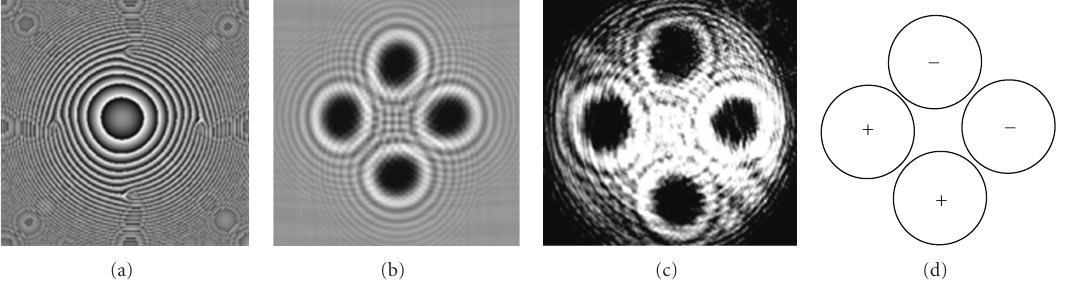
Figure 4: Fresnel lens with two positive and two negative charge vortices embedded at o ff -axis locations. (a) Phase distribution displayed on SLM. (b) Simulated intensity distribution near the focal plane. (c) Experimentally observed intensity distribution near the focal plane. (d) Distribution of topological charge in the intensity pattern.